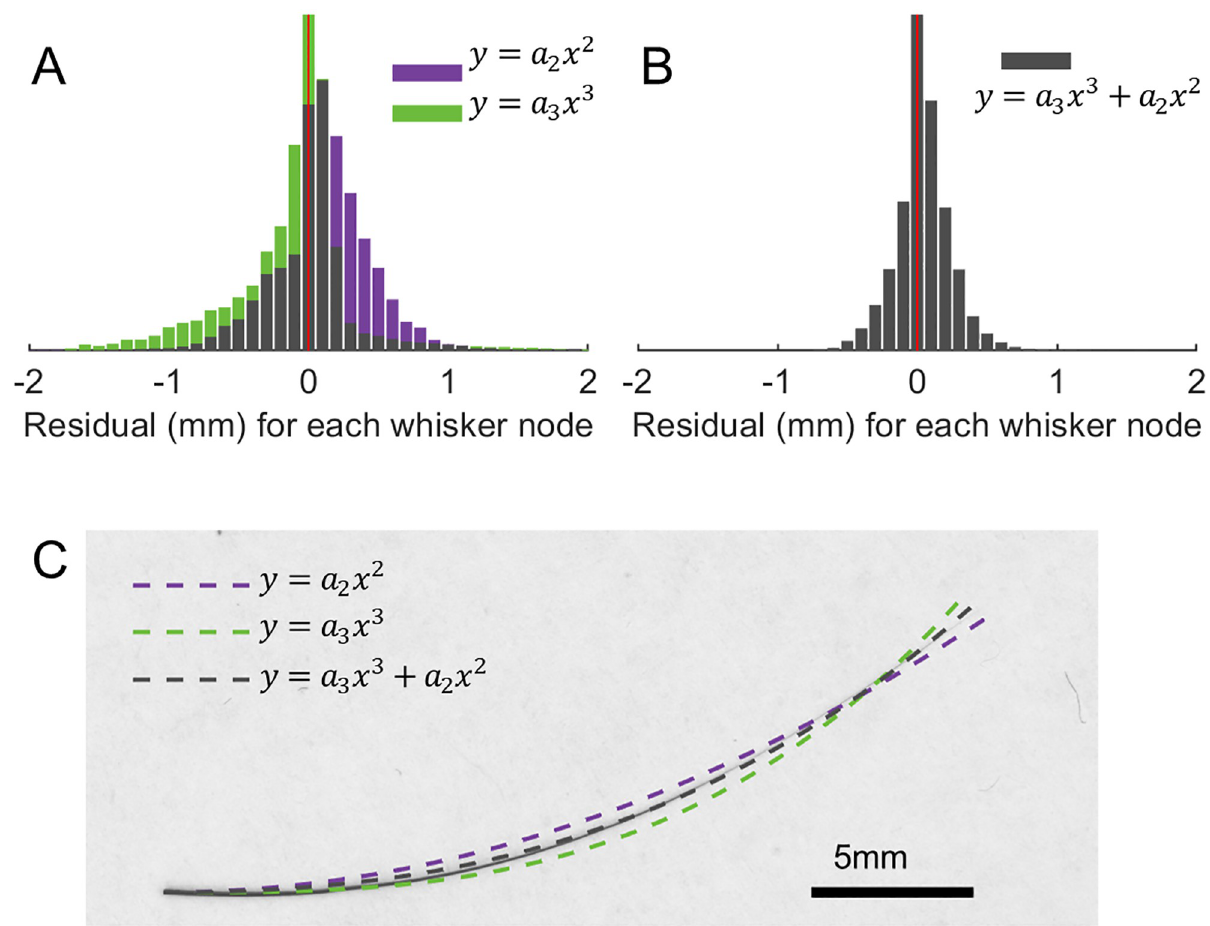
Fig 3. The quadratic and cubic terms in a polynomial model make different contributions to the fit. (A) The histograms of residuals for rat whiskers using the model y = a 2 x 2 (purple) and y = a 3 x 3 (green) are skewed to the opposite sides of 0 (red vertical line). (B) The histogram of residuals for rat whiskers using the model y = a 3 x 3 +a 2 x 2 is shown; skewness is near zero. (C) Different curve fits are plotted for an exemplar scanned rat whisker. It can be observed that the quadratic and cubic models generate residuals on opposite sides of the whisker. The whisker shape lies between the two well- fit single-parameter curves, y = a 2 x 2 and y = a 3 x 3